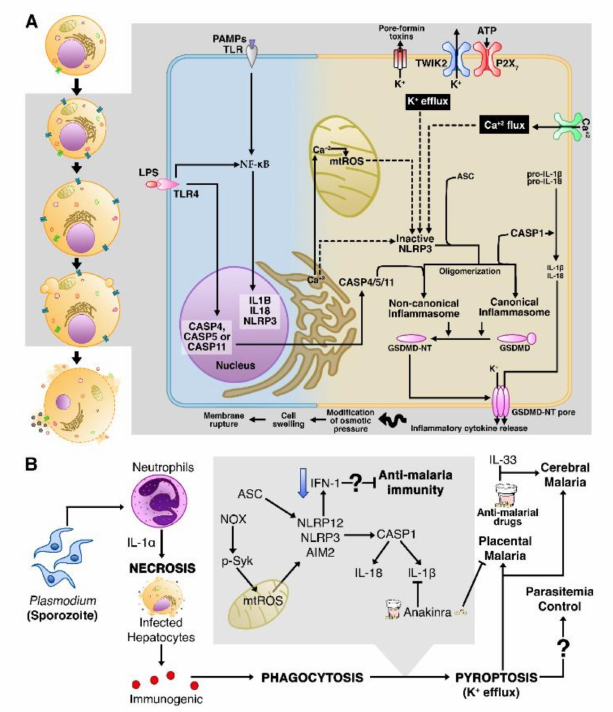
Figure 4. Accidental necrosis and pyroptosis act together in the pathogenesis of severe malaria. ( A ) A simplified overview of the canonical and non-canonical pathways of pyroptosis. On the left side of the figure (white background), as morphological characteristics, pyroptotic cells display cell swelling, the formation of pyroptotic bodies, and plasma membrane disruption. On the right, the molecular events of pyroptosis. ( B ) Upon Plasmodium infection, the IL-1 α -dependent cells’ necrosis is accompanied by the release of immunogenic contents that contribute to the assembly of inflammasomes, by a mechanism to be determined. Considering that inflammasomes participate in CM and PM immunopathology, some drugs are being developed to inhibit the expression of genes involved in pyroptosis. TWIK2: two-pore domain K + channel; P2 × 7: P2X purinoceptor